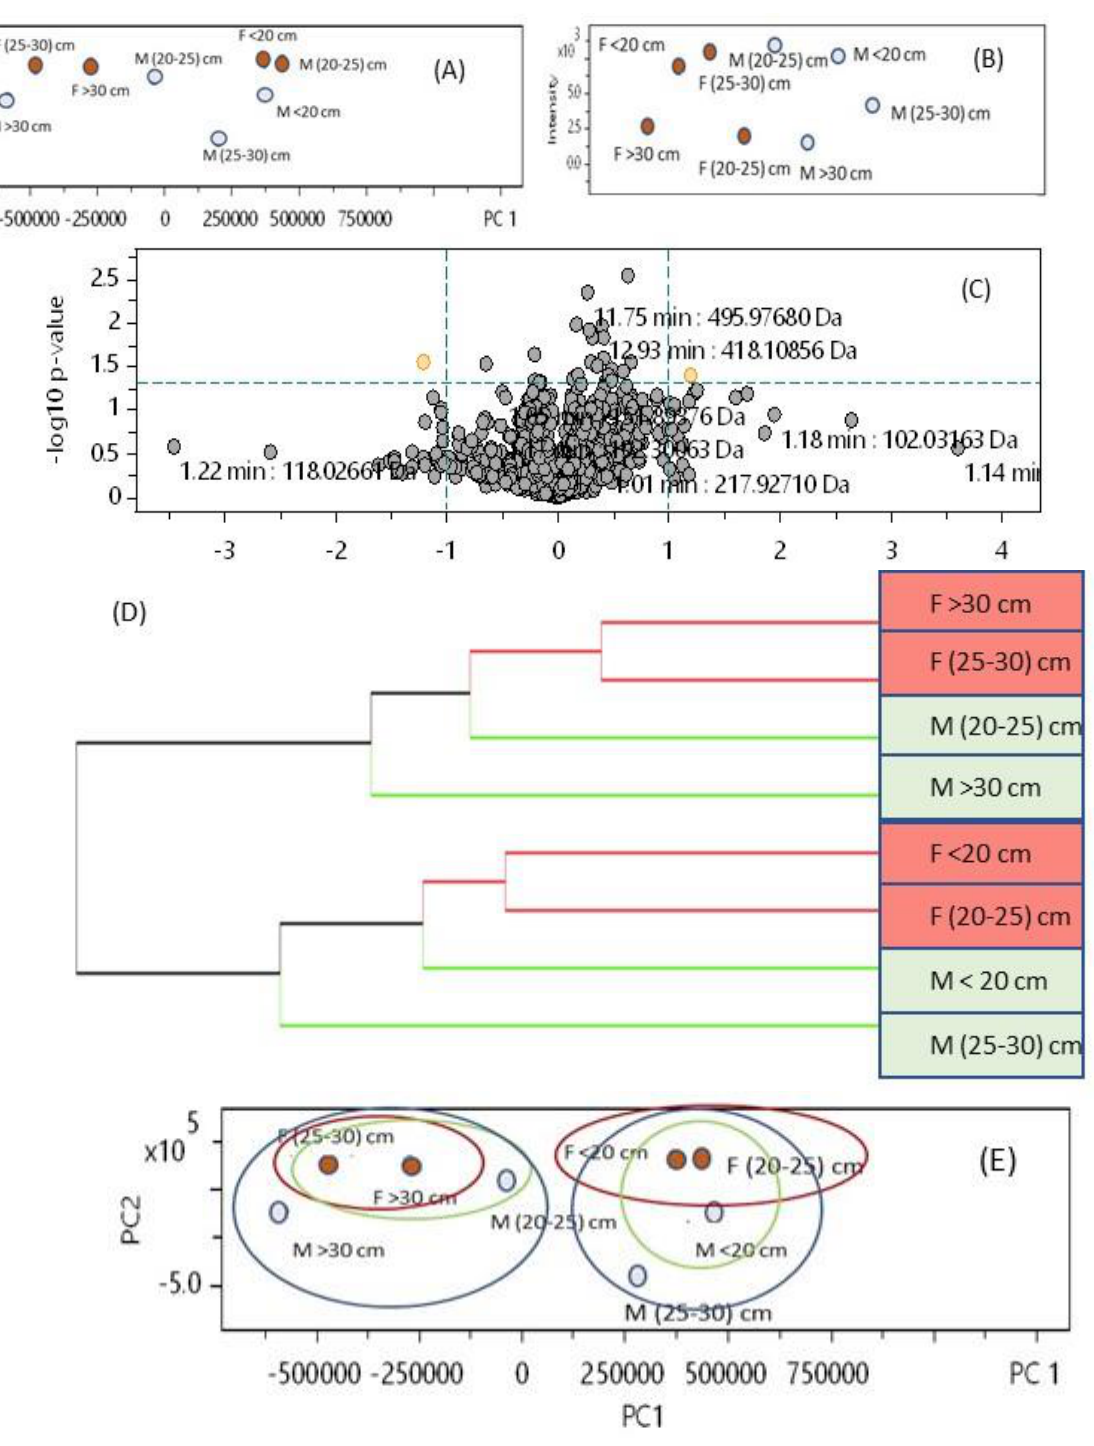
Figure 9. Statistical analysis of the peaks detected in the LC-HRMS analysis of female and male samples obtained at 100 °C: ( A ) PCA; ( B ) intensities; ( C ) volcano plot; ( D ) clustering; ( E ) PCA with groups assembled.